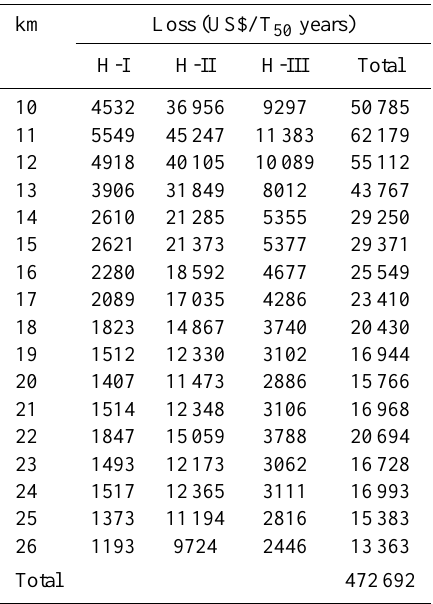
Table 5. Direct specific risk per kilometre of the railway line.